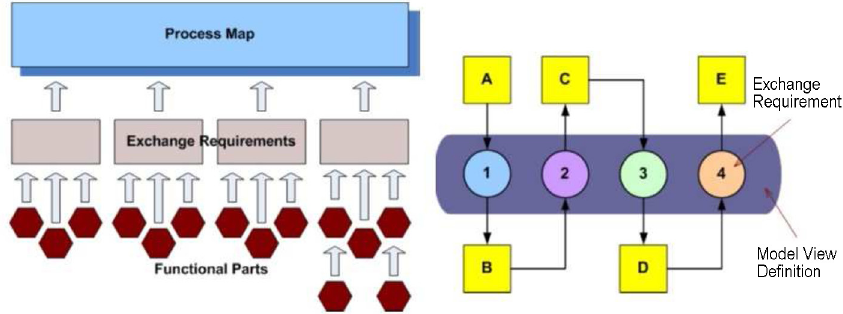
Fig. 3. In the right process maps, exchange requirements and Functional parts are shown. In the left the schema for model view definitions can be seen (Wix, Karlshoej